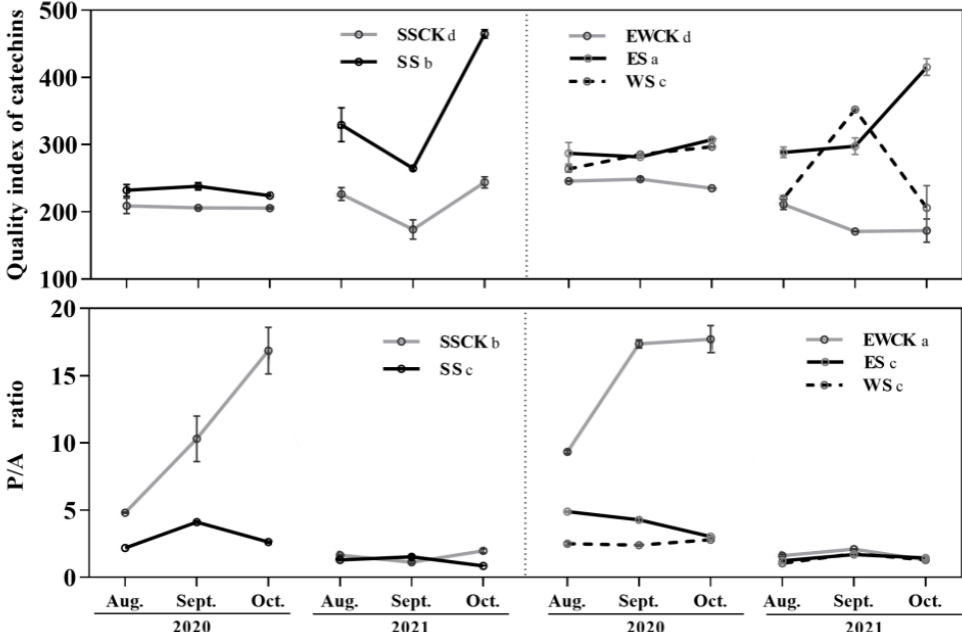
Figure 4. Catechin quality index and P/A ratio of tea plants under the ecological shading treatment with roadside trees in a tea plantation. (Note: different lowercase letters indicate significant differences among the ecological-shade treatments, and the control no-shading treatments, using the LSD test at p <